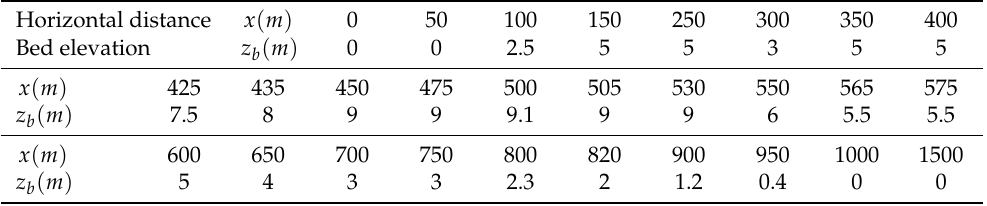
Table 1. Bed elevation z b for irregular